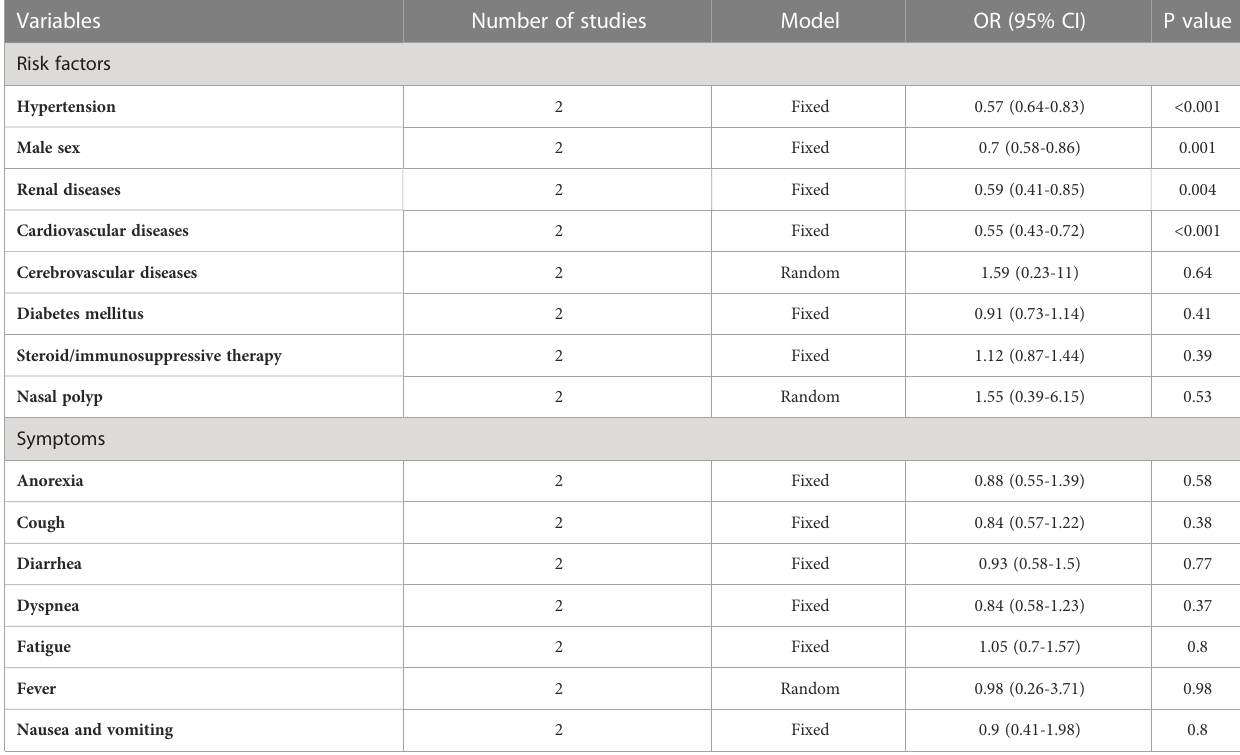
TABLE 3 Risk factors and symptoms of COVID-19 with chronic rhinosinusitis compared to the control